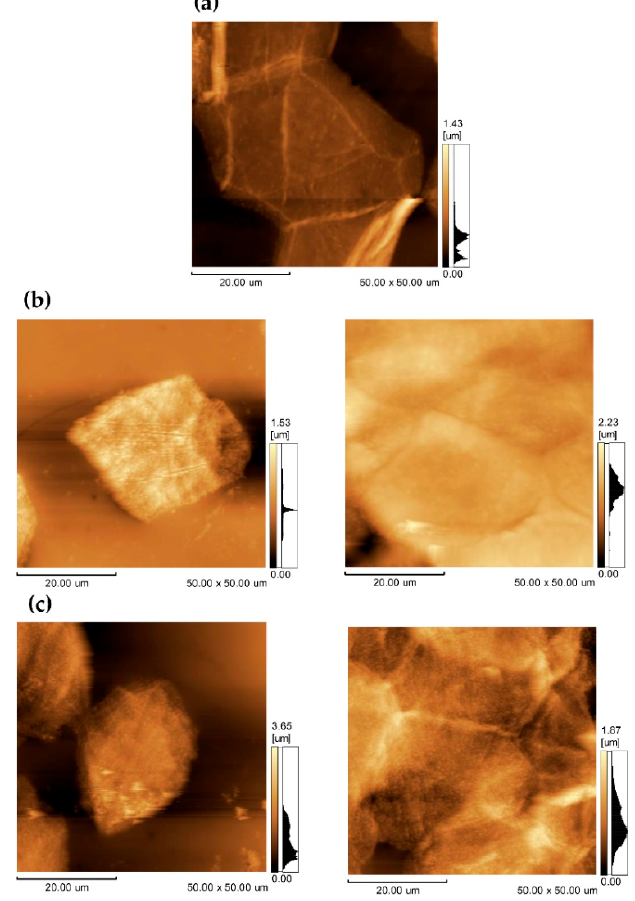
Figure 6. Photomicrographs obtained by AFM, in tapping phase mode, of adhesive tapes containing fragments of the stratum corneum from a healthy patient ( a ), from a patient with moderate AD who used the CBlank cream ( b ), and from a patient with moderate AD who used the CPropolis cream ( c ). The images of AD patients show the stratum corneum before treatment in the left panel and after 60 days of treatment in the right panel.